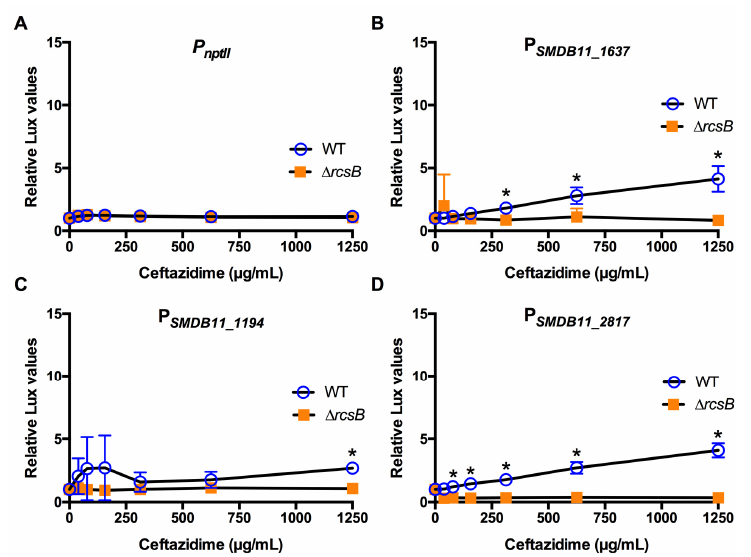
Figure 6. Effect of the cell wall activating antibiotic ceftazidime on Rcs-activated promoters ( A – D ). Relative luminescence values were determined by dividing luminescence by optical density after 4 h of antibiotic challenge. The nptII promoter ( A ) was unaffected by ceftazidime. The Rcs-dependent promoters ( B – D ) were activated to a greater extent in the WT than the Rcs-defective ∆ rcsB mutant. Mean and standard deviation are shown ( n = 6–9 are shown). Asterisks (*) indicate statistical differences between groups at the indicated concentrations, p < 0.05.